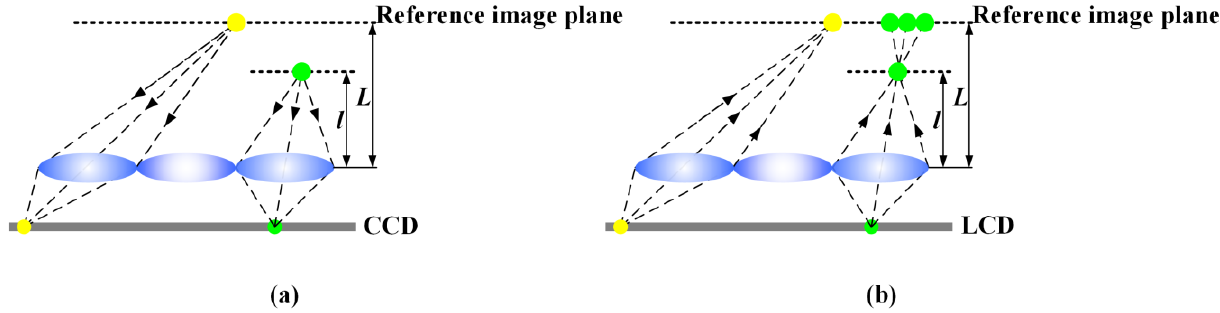
Figure 1. Facet braiding effect for point objects in ( a ) pickup process and ( b ) display process.